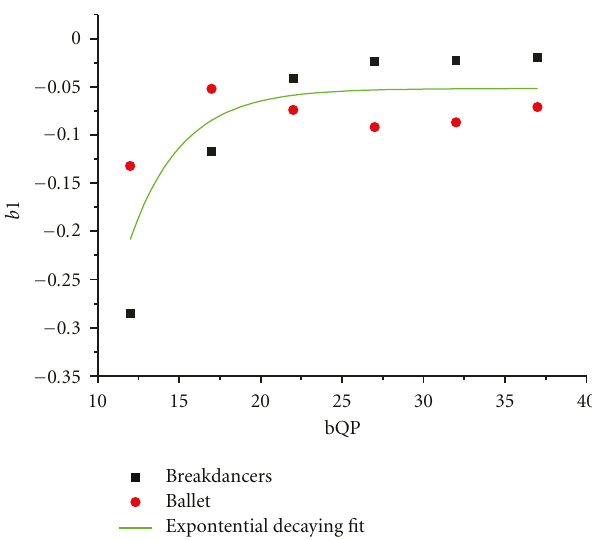
Figure 13: The relation maps of image quality to Δ QP.